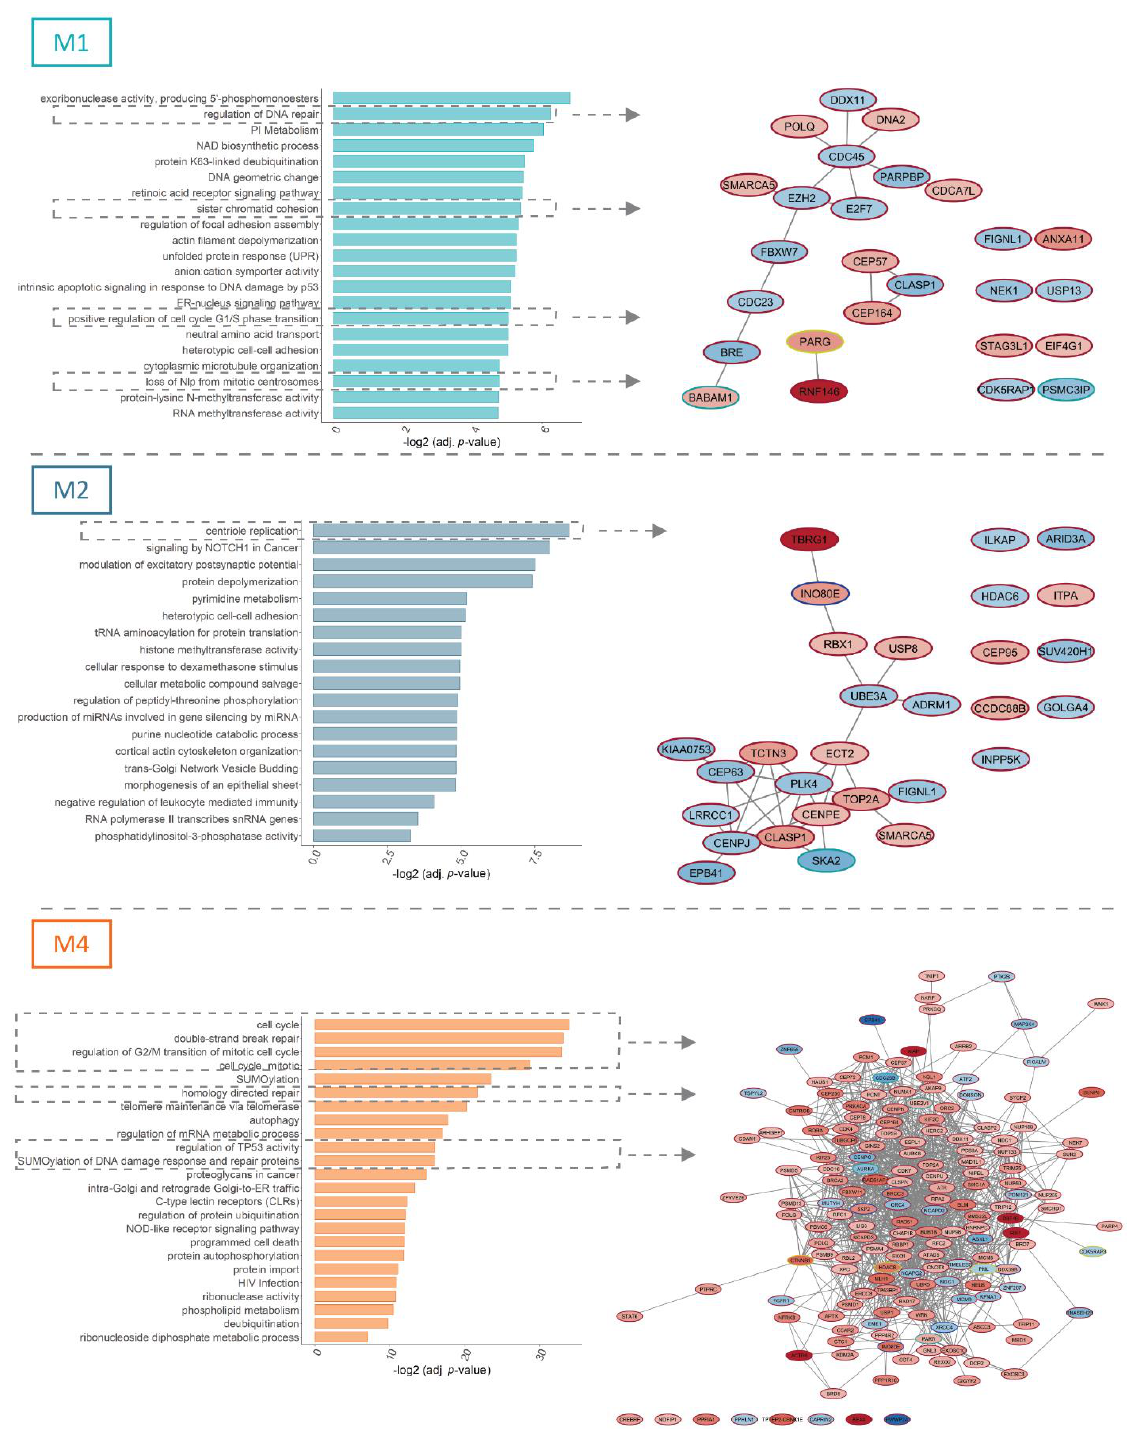
Figure 2. Functional analysis of differentially spliced genes in relation to concomitant FLT3 -ITD and NPM1 mutations. The figure depicts functional enrichment among significant differential splicing events (FDR < 0.05) in relation to concomitant FLT3 -ITD and NPM1 mutations in M1, M2 and M4 FAB subtypes with a minimal splicing difference between the two groups of 0.1 (|ΔPSI| > 0.1). For each FAB subtype, processes related to cell cycle control and DNA damage response are highlighted and depicted as protein networks. Node fill color signifies the ΔPSI value for each differential splicing event, while the color of the node edge codes for the type of differential splicing event: alternative 3 ′ splice site selection (A3SS, blue), alternative 5 ′ splice site selection (A5SS, turquoise), retained intron (RI, yellow) and skipped exon (SE, brown).